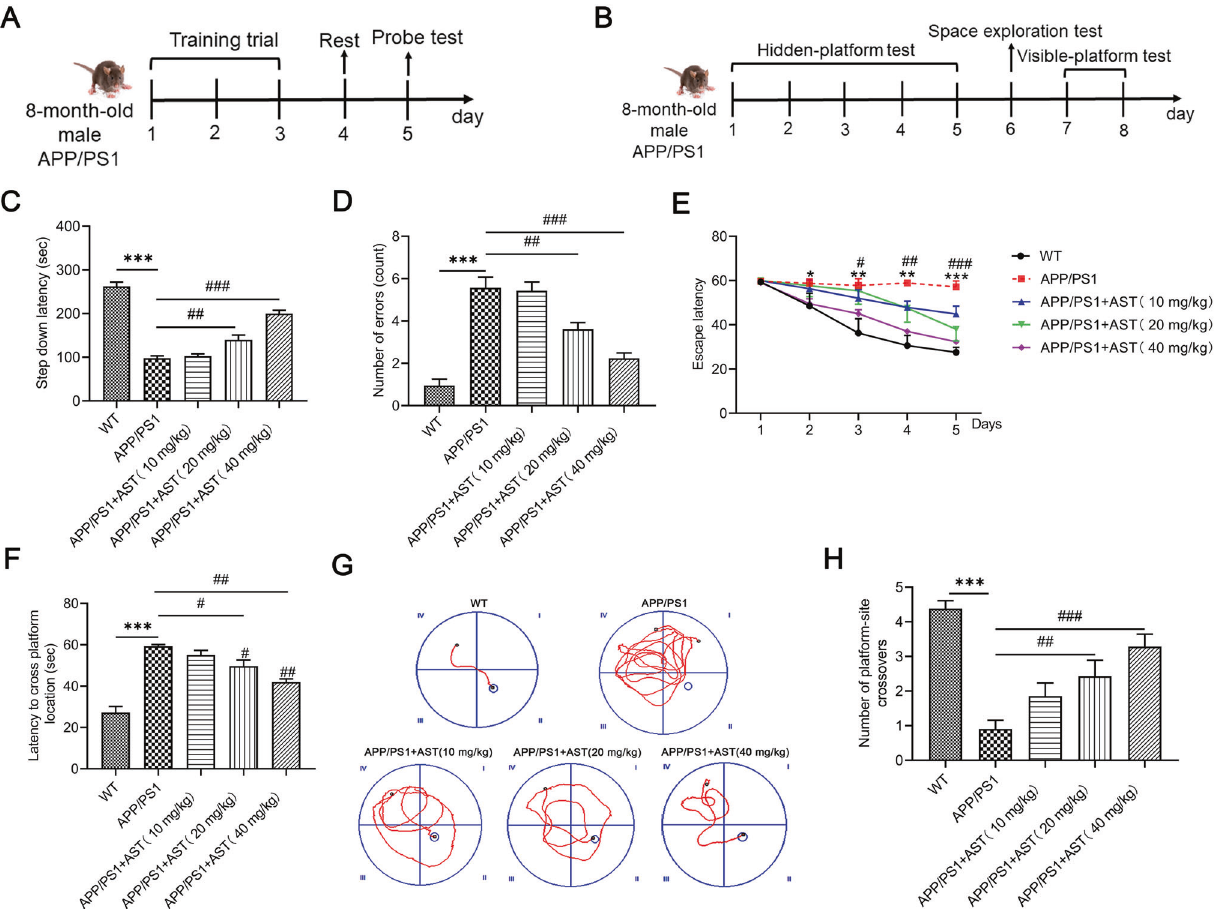
Fig. 1 AST improved the cognitive dysfunction of APP/PS1 mice in the step-down avoidance (SDA) test and the Morris water maze (MWM) test. A , B Timelines of the mice SDA and MWM test. C , D The step-down latency and the number of errors of mice in the SDA test. E The escape latency of mice to arrive at the platform during the positioning navigation test in the MWM test (Day 1 – 5). F , G Time of mice to reach the target platform and swimming trajectory diagrams of mice during the space exploration in the MWM test (Day 6). H The number of mice crossing the target platform during the visible platform period in the MWM test (Day 7 – 8). Data were presented as mean ± SD, n = 7/ group. * p < 0.05, ** p < 0.01 and *** p < 0.001 vs WT group, # p < 0.05, ## p < 0.01 and ### p < 0.001 vs APP/PS1